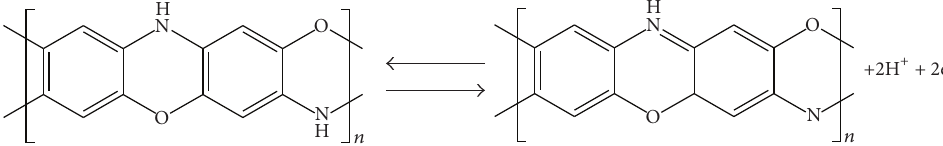
F 4: Reaction scheme of POAP redox switching including oxidized and reduced forms